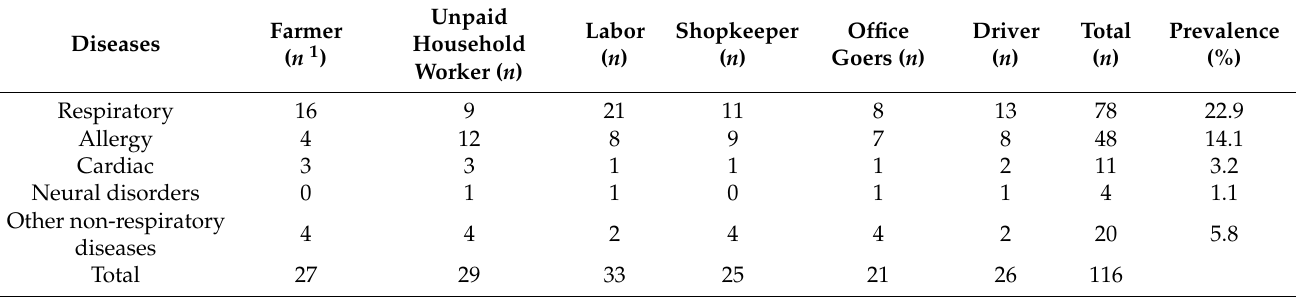
Table 3. Prevalence of diseases among different